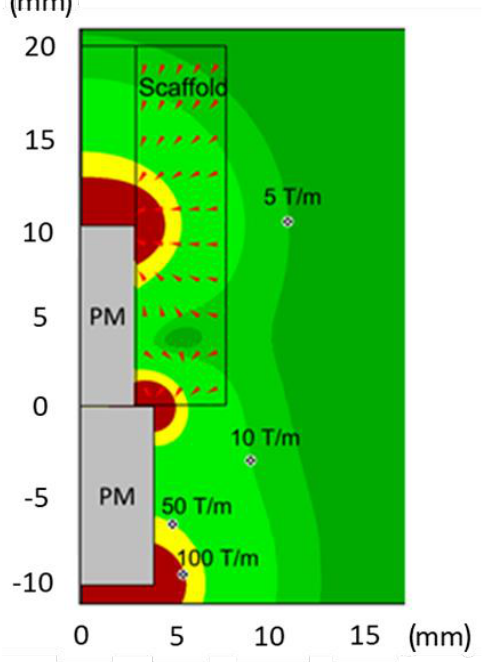
Figure 2. Directions of magnetic forces acting on MNPs dispersed inside the scaffold. The color distribution shows isolines of the magnetic field gradient, which grows from dark green to brown.